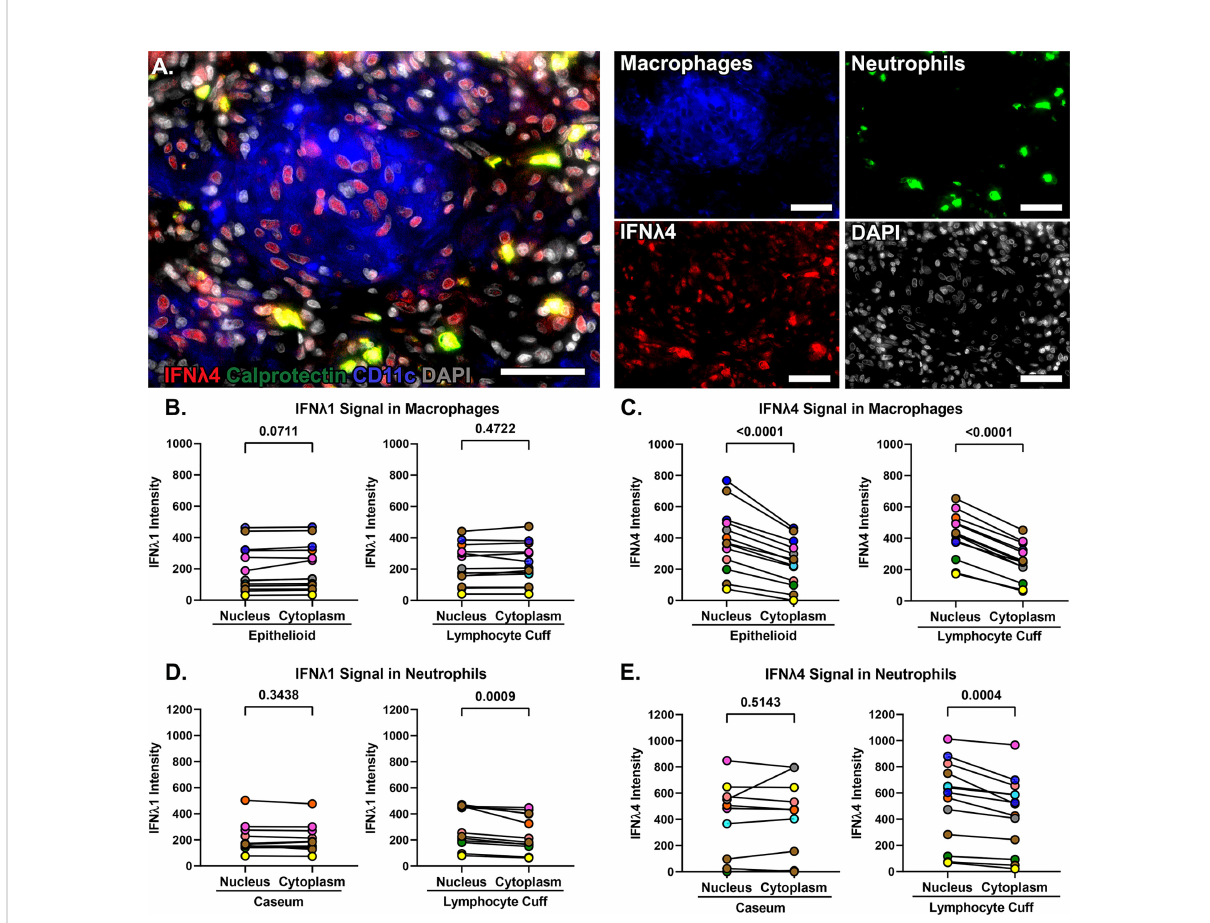
FIGURE 7 IFN l 1 and IFN l 4 differ in subcellular localization in macrophages. (A) IFN l 4 (red) localization in calprotectin+ neutrophils (green) and in the nuclei (grey) of CD11c+ macrophages (blue). 40x magni fi cation, scale bars represent 50 um. (B) Comparison of IFN l 1 intensity in the nuclei and cytoplasm of epithelioid (left) and lymphocyte cuff macrophages (right). (C) Comparison of IFN l 4 intensity in the nuclei and cytoplasm of epithelioid (left) and lymphocyte cuff macrophages (right). (D) Comparison of IFN l 1 intensity in the nuclei and cytoplasm of caseum (left) and lymphocyte cuff neutrophils (right). (E) Comparison of IFN l 4 intensity in the nuclei and cytoplasm of caseum (left) and lymphocyte cuff neutrophils (right). In B-E, n=13 granulomas and statistical comparisons done by paired t